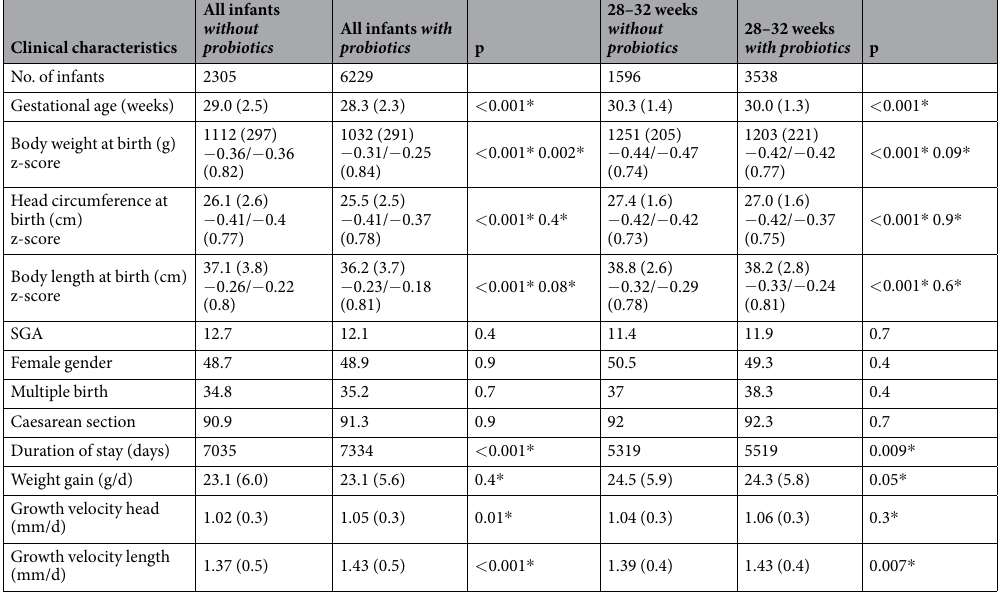
Table 1. Clinical characteristics according to prophylactic use of Lactobacillus acidophilus/Bifidobacterium infantis probiotics. Legend: Continuous variables are shown as mean (SD); z-scores are shown as mean/median (SD). Categorical variables are shown as percent. p-values were derived from Fisher’s exact test or Mann- Whitney-U test if indicated ( * ), SGA, small for gestational age ( < 10th percentile of birth weight adjusted to gestational age). Growth velocity and weight gain were calculated by differences between parameters at birth and respective measures at discharge/number of days (duration of